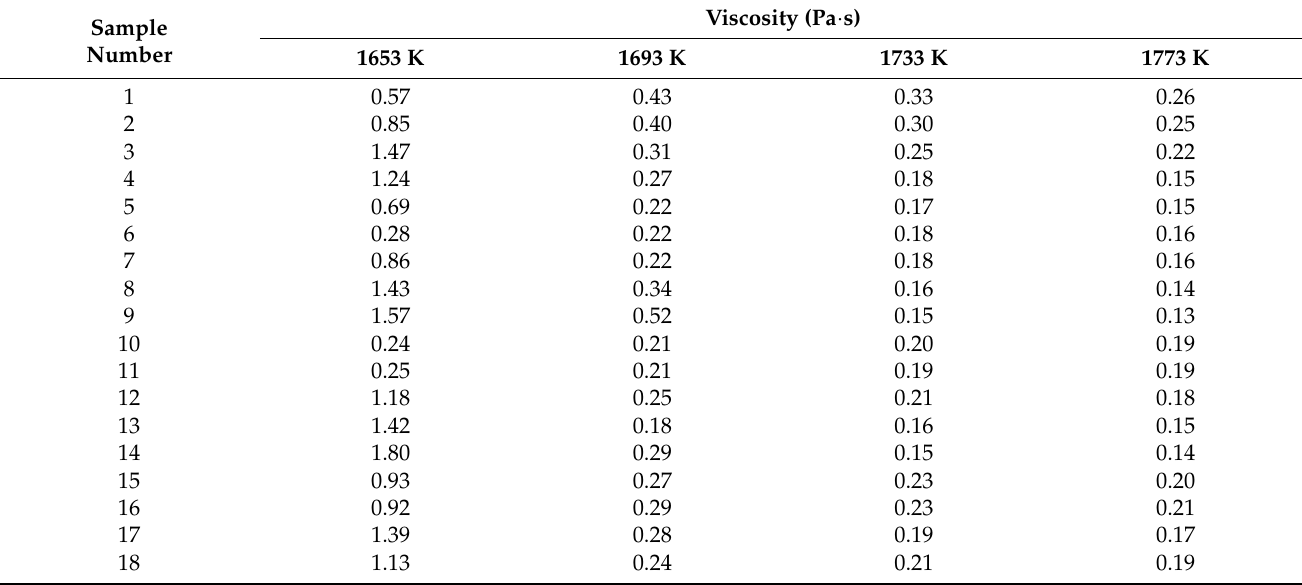
Table 2. Measured viscosity values of the CaO-SiO 2 -MgO-Al 2 O 3 -TiO 2 slags.